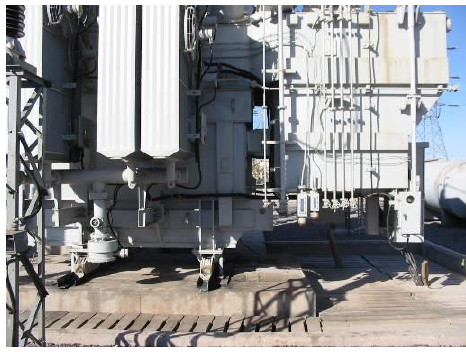
Figure 2. Power Transformer of Bam power substation after